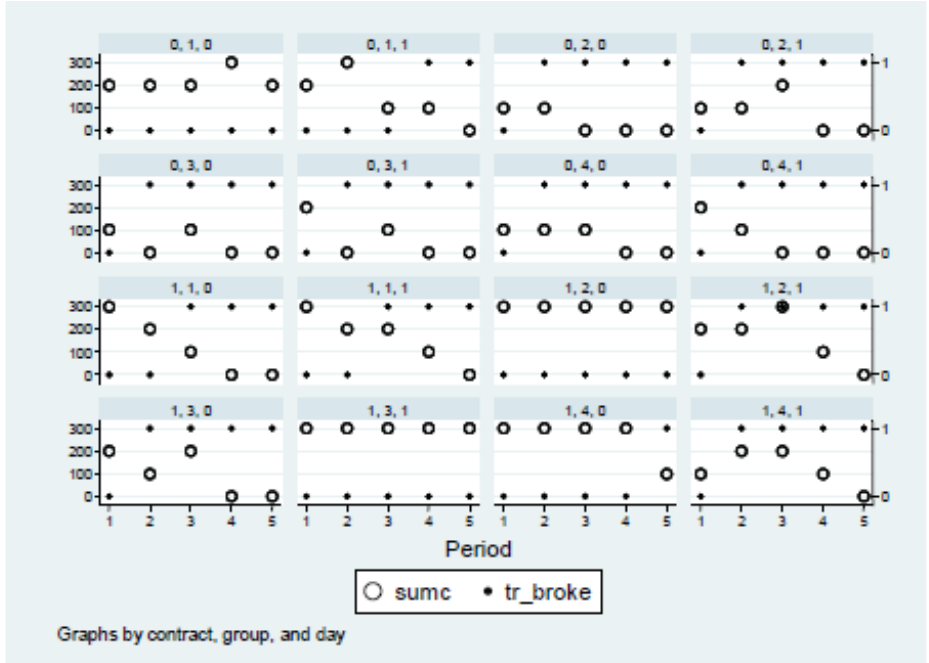
Figure 2: Total group contributions (hollow circles, left y-axis) and whether trigger is broken or not (right y-axis black discs) over periods, contingent on contract availability (1=Prize; 0=No Prize), group (1-4), and day (0=First day; 1=Second